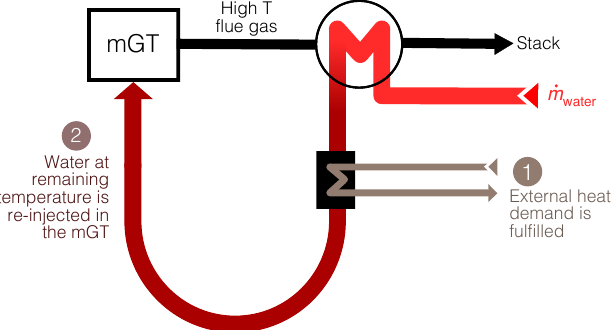
Figure 3. The exhaust gases of the mHAT unit warm up water in the economiser. This hot water is first used to fulfil the external heating needs (step 1). If the water temperature is high enough, they are then injected in the saturation tower (step